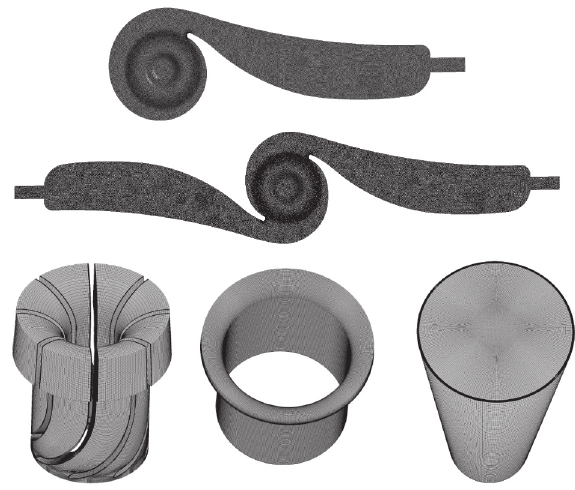
Figure 3: Mesh of the model pump.